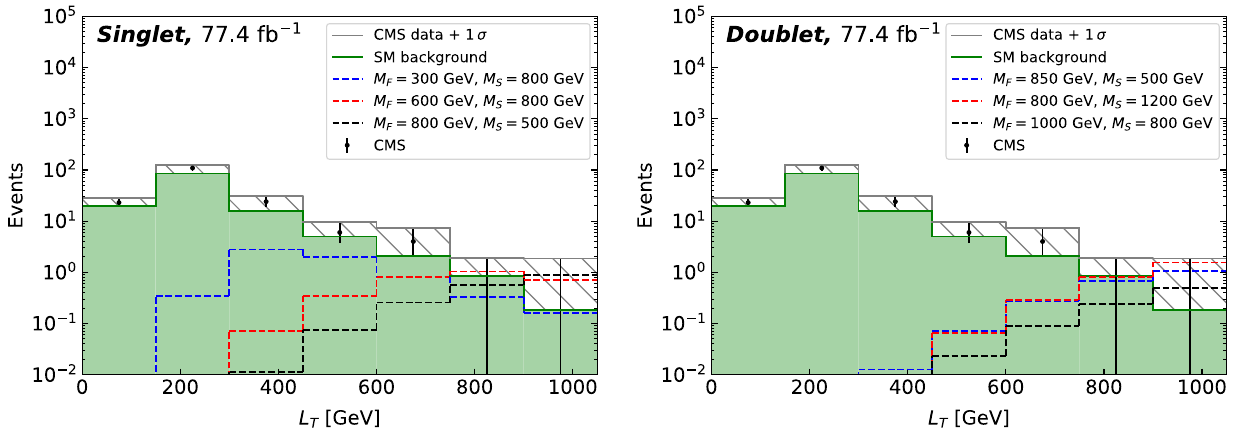
Fig. 7 L T distributions in the singlet (left) and the doublet model (right) for SM background processes in our simulation (green shaded area) and for the different benchmark masses of vector-like fermions and new scalars (yellow circles in Fig. 6). The observables are shown